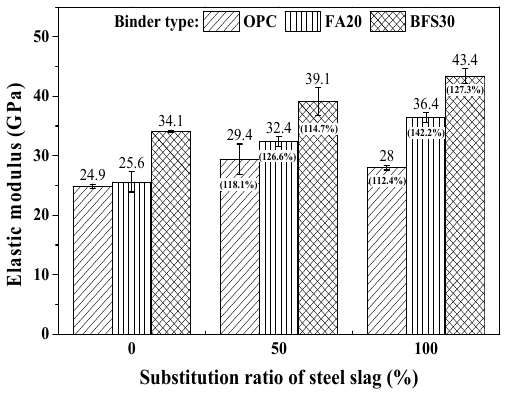
Figure 6. Results of modulus elastic.